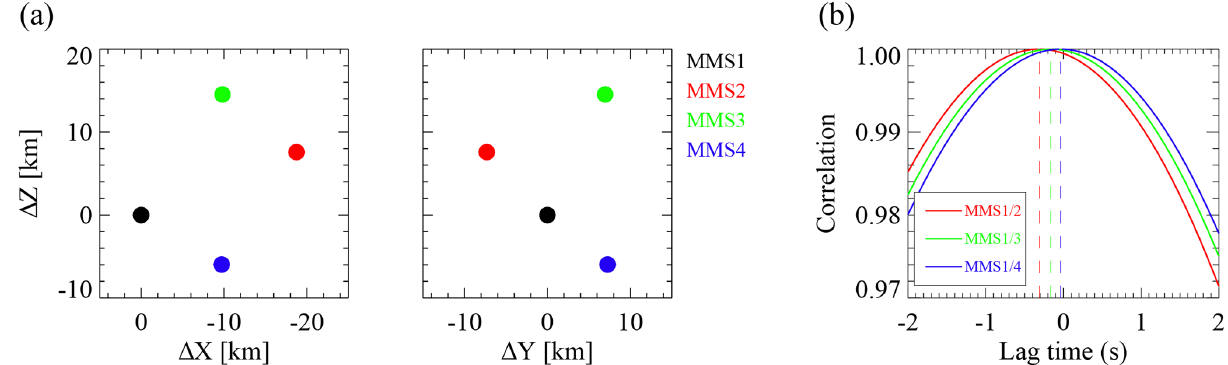
Figure 2. (a) Positions of the MMS spacecraft relative to MMS1 at 20:52UT in the x – z (left) and y – z (right) planes. (b) The cross- correlations between MMS1 and the three other MMS satellites are calculated by using B Z in the interval